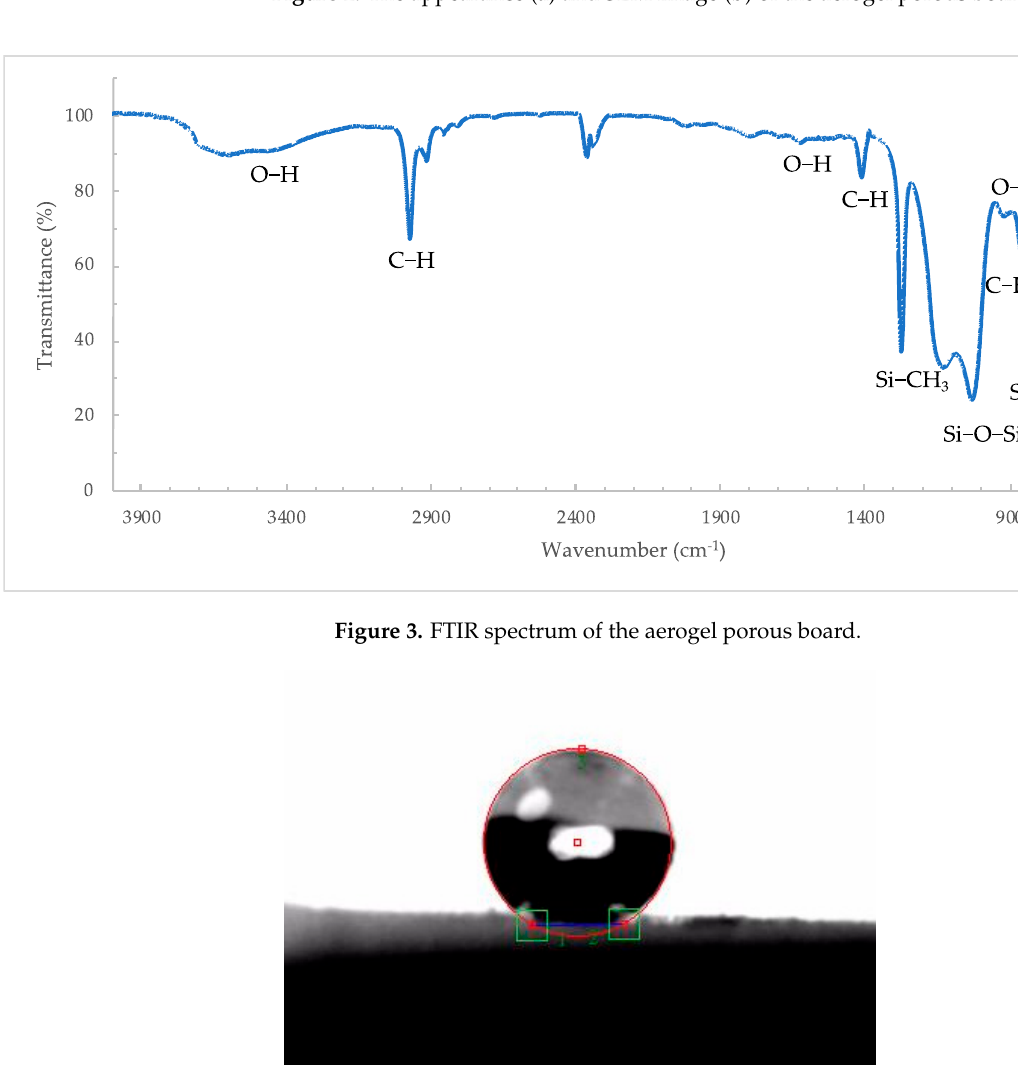
Figure 2. The appearance ( a ) and SEM image ( b ) of the aerogel porous board.